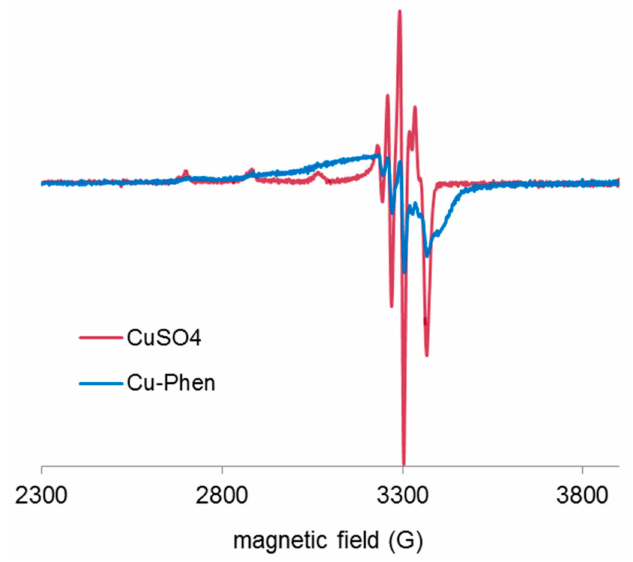
Figure 9. Experimental X-band EPR spectra recorded at 100 K in frozen aqueous solutions of CuSO 4 and Cu-Phen at pH 12.3, with Cu:Phen molar ratio = 1:2 and [Cu] = 1.5